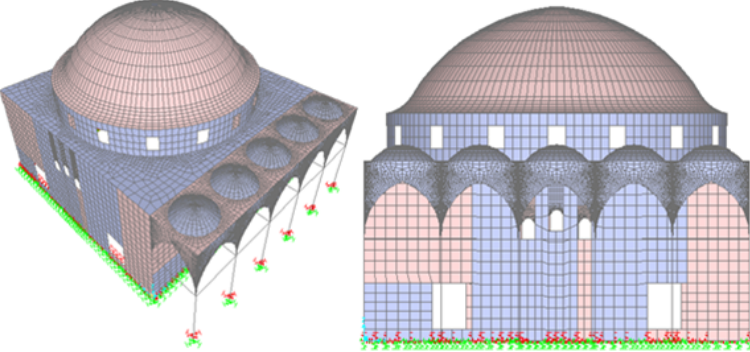
Figure 3. Finite element model of the mosque with 16 window